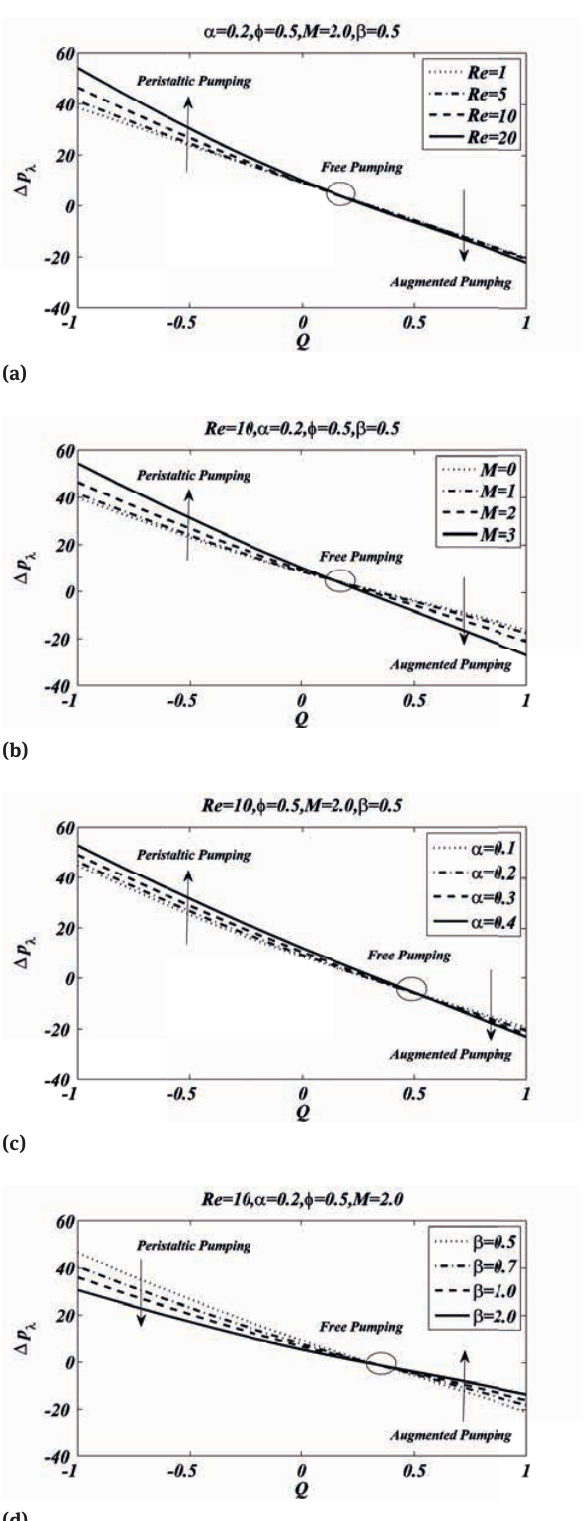
Fig. 13: Pressure distribution for different value for (a) Re (b) M (c) α ( d ) β